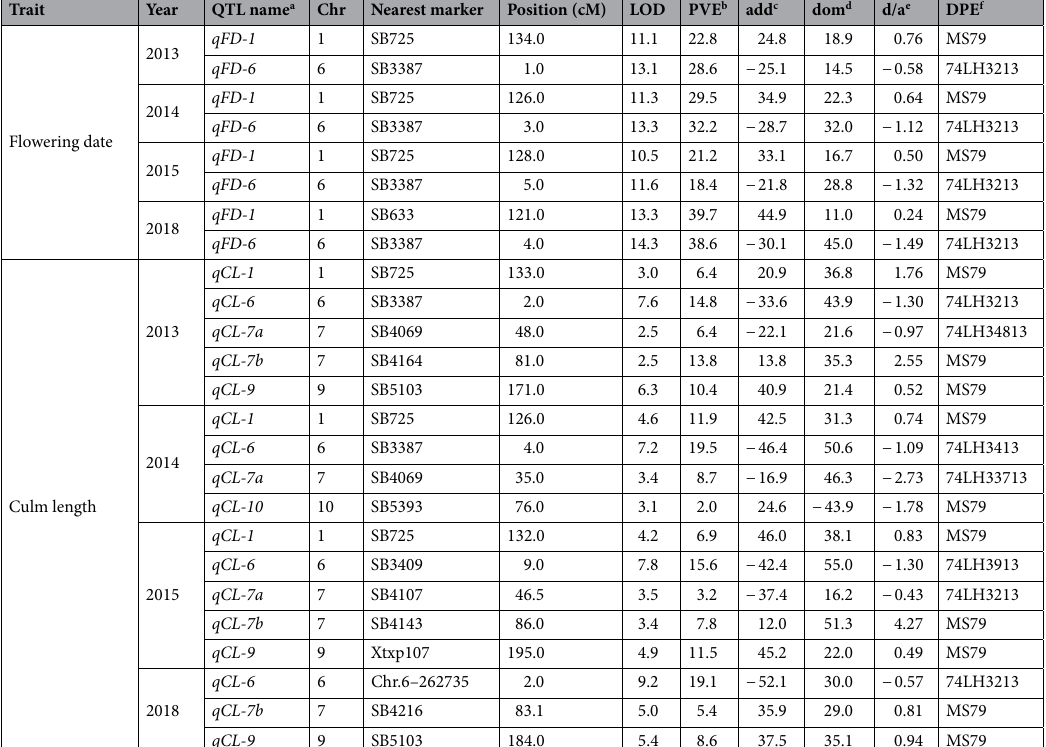
Table 1. QTLs for flowering date and culm length detected from 2013 to 2015 and in 2018. a QTLs were named after each trait and chromosome number. b Percentage of variance explained. c Additive effect of the MS79 allele. d Dominance effect e ratio of dominant to additive effect. f Direction of the phenotypic